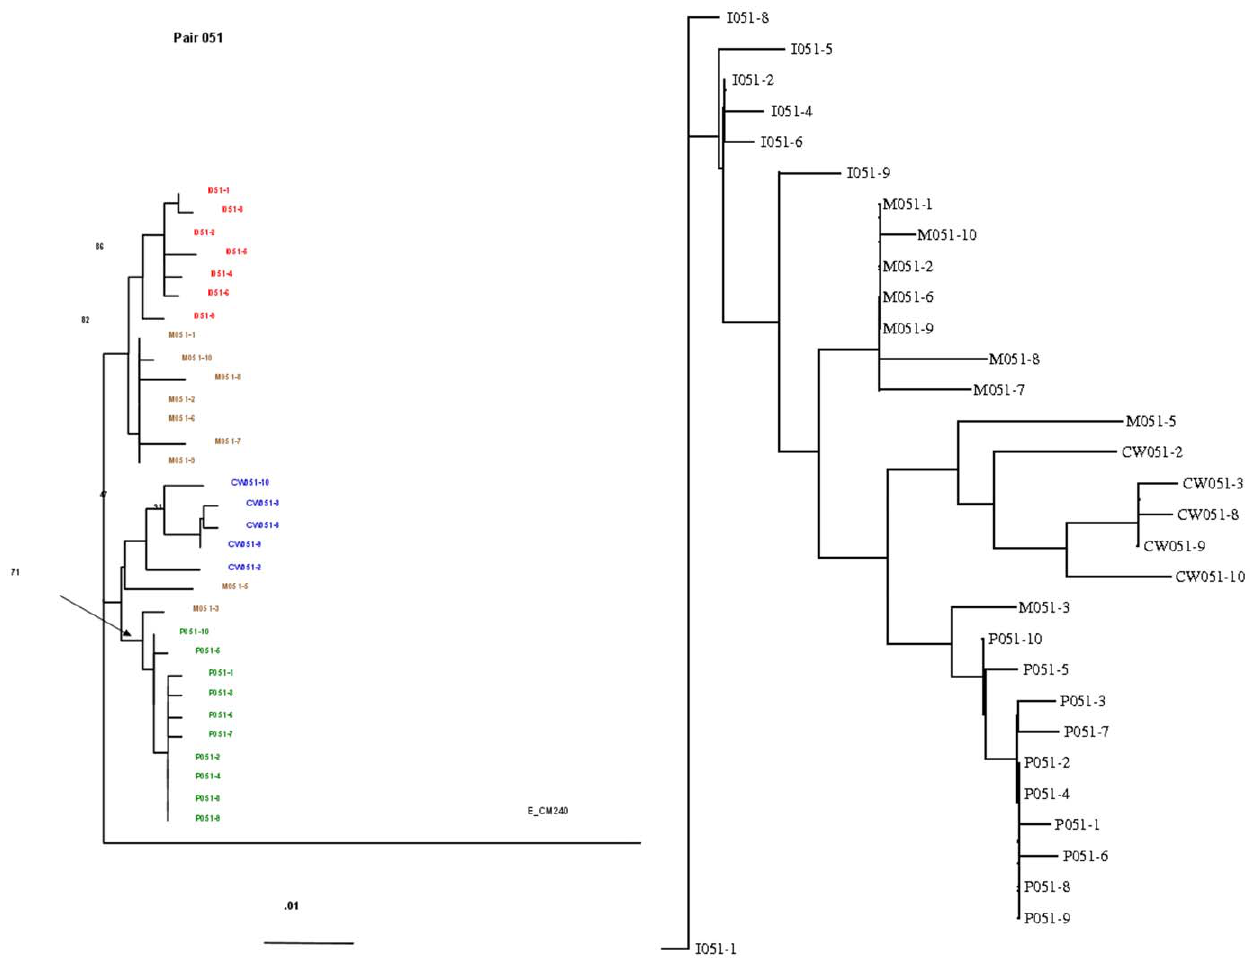
Figure 8. Neighbor-joining string-based phylogenetic tree vs. W-curve-based tree. Envelop C2-V5 from the 051 mother/infant pair grouping from a study previously conducted in Thailand [17]. The string based tree at the left compares the infant sequences to the maternal viruses from different compartments and CM240 as a reference subtype: (I) infant peripheral blood mononuclear cell (PBMC) DNA-derived sequences; M, maternal PBMC DNA-derived sequences; P, maternal plasma-derived sequences; CW, cervical secretion-derived sequences. Numbers at the nodes represent the maximum parsimony bootstrap value. Branch lengths between the sequences are proportionate to the scale bar and indicate the number of mutations per base position per unit time. The tree at the right is the W-curve-based tree. Note the similarity in the clustering patterns. The remaining phenograms are available in the supporting data for this paper [11].